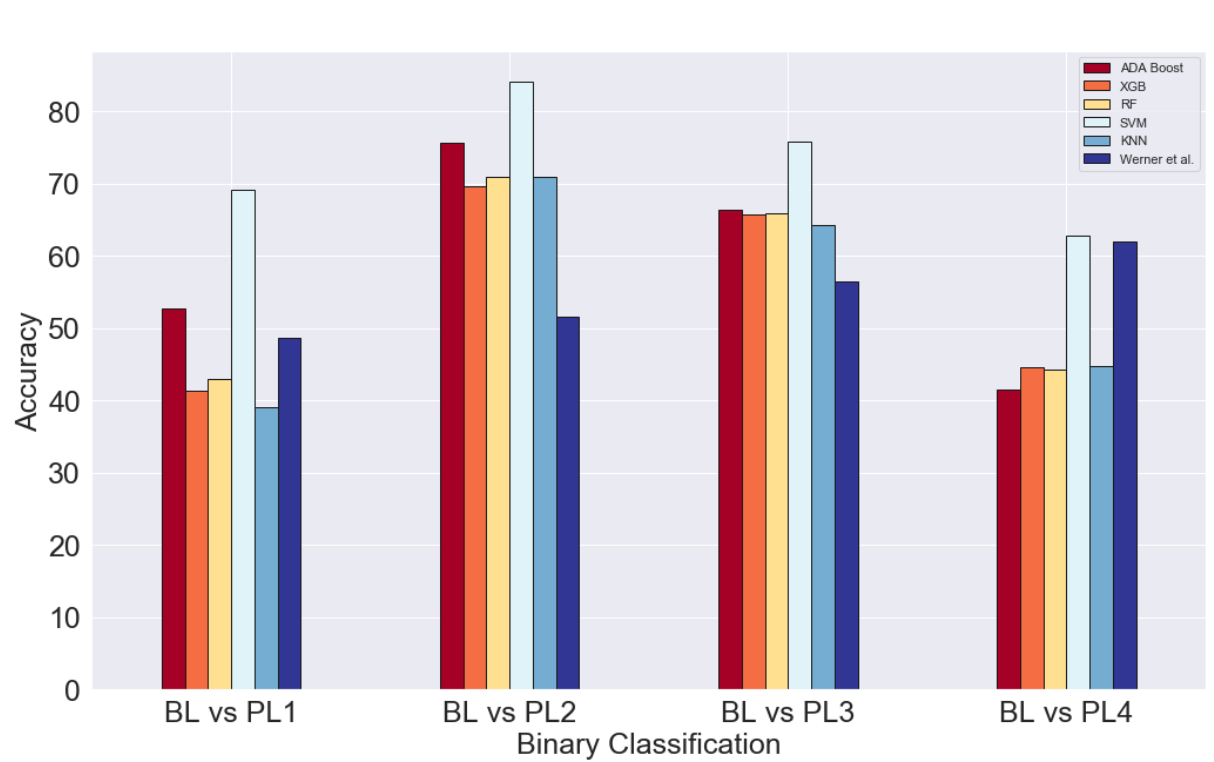
Figure 2. Validation accuracy of all classifiers on BioVid features. BL: baseline; PL: pain level; KNN: k-nearest neighbor; RF: random forest; SVM: support vector machine; XGB: XGBoost.